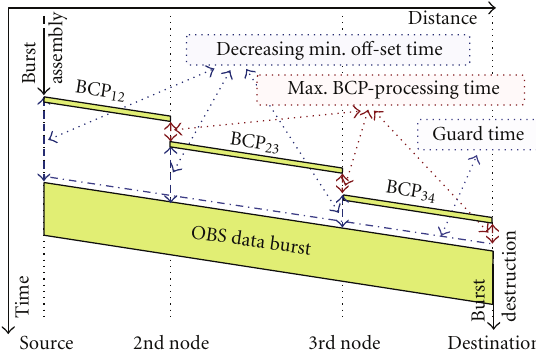
Figure 11: Timing of basic JET